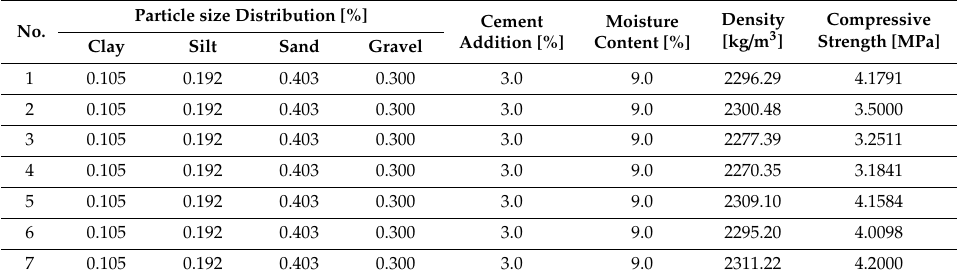
Table A1. The set of features of 373 samples and the compressive test result are presented in Appendix